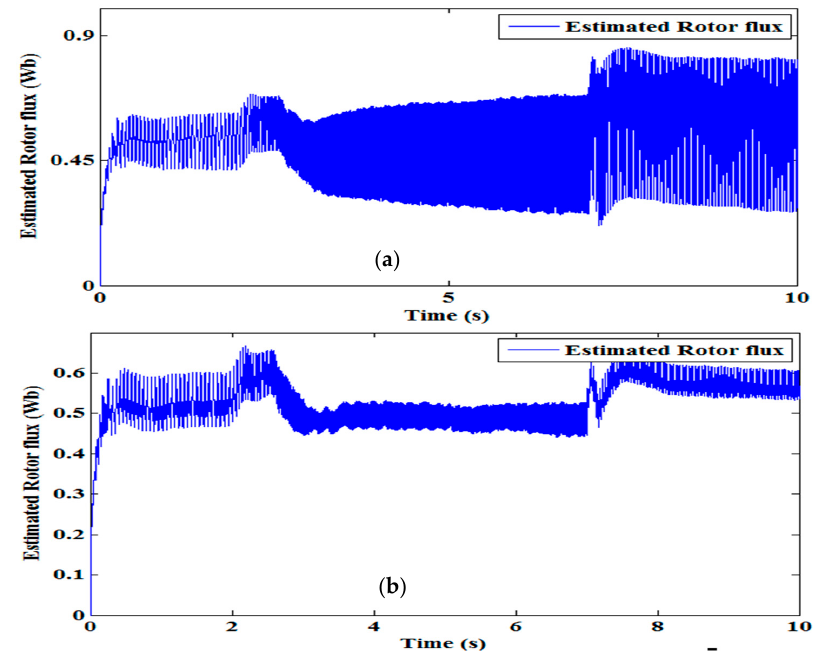
Figure 17. Estimated rotor flux of ( a ) SMLO 1; and ( b ) SMLO 2.